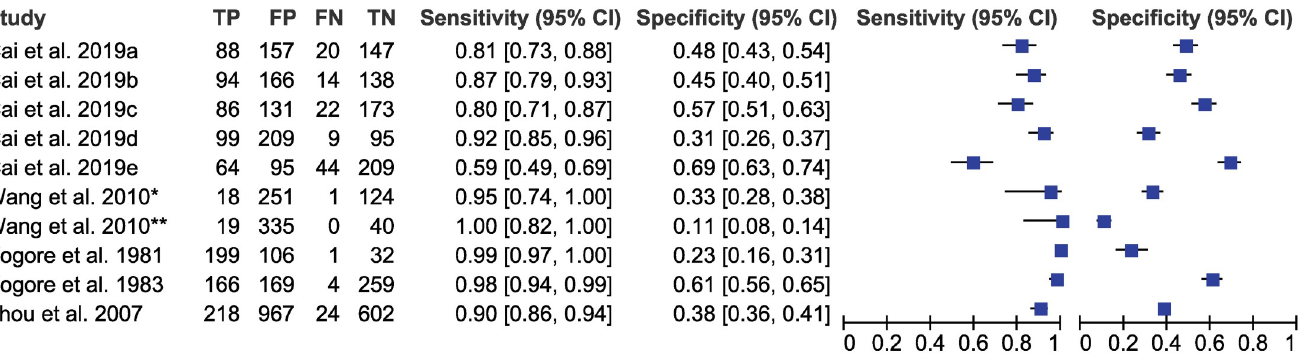
Negative Predictive Value